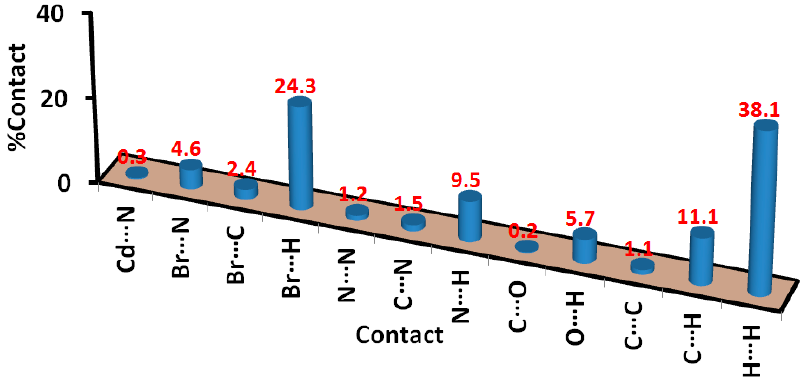
Figure 4. Percentages of all intermolecular contacts in the [Cd(BPMT)Br 2 ] complex.